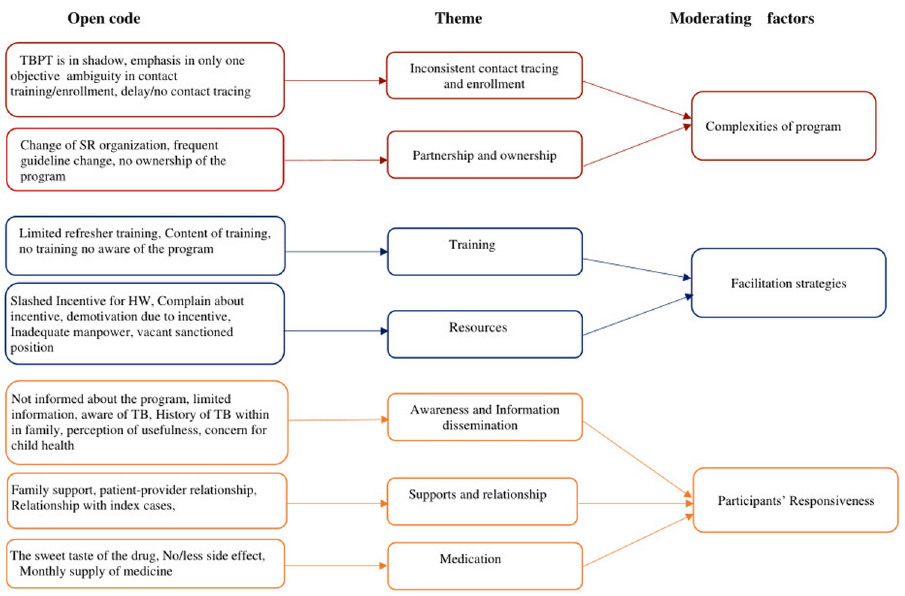
Fig 2. Moderating factors for the implementation of TBPT